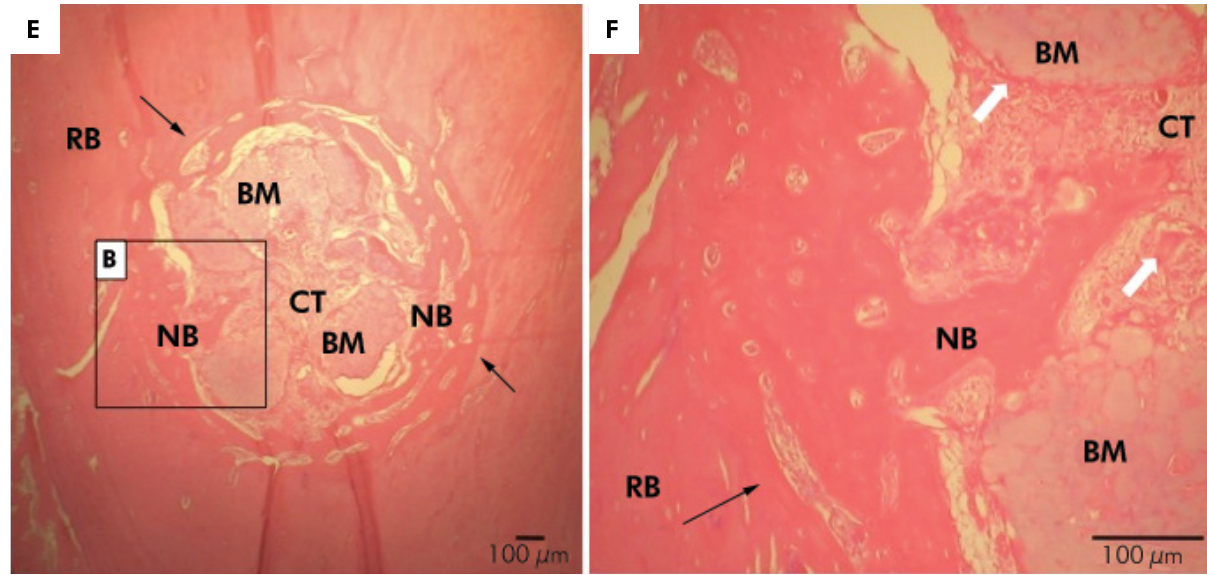
Figure 5. Representative photomicrographs of the SrHA group. Defect area (black arrow); newly formed bone (NB); central area of the defect composed of loose connective tissue (CT) with sparse chronic inflammatory infiltrate and multinucleated giant cells (white arrows) surrounding the biomaterial particles